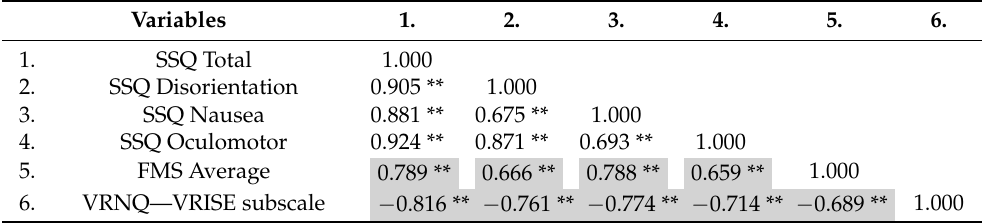
Table 6. Correlation matrix for LA_RFH condition—Spearman ( ρ ) correlation coefficients for com- bined VRISE measures ( n = 6).